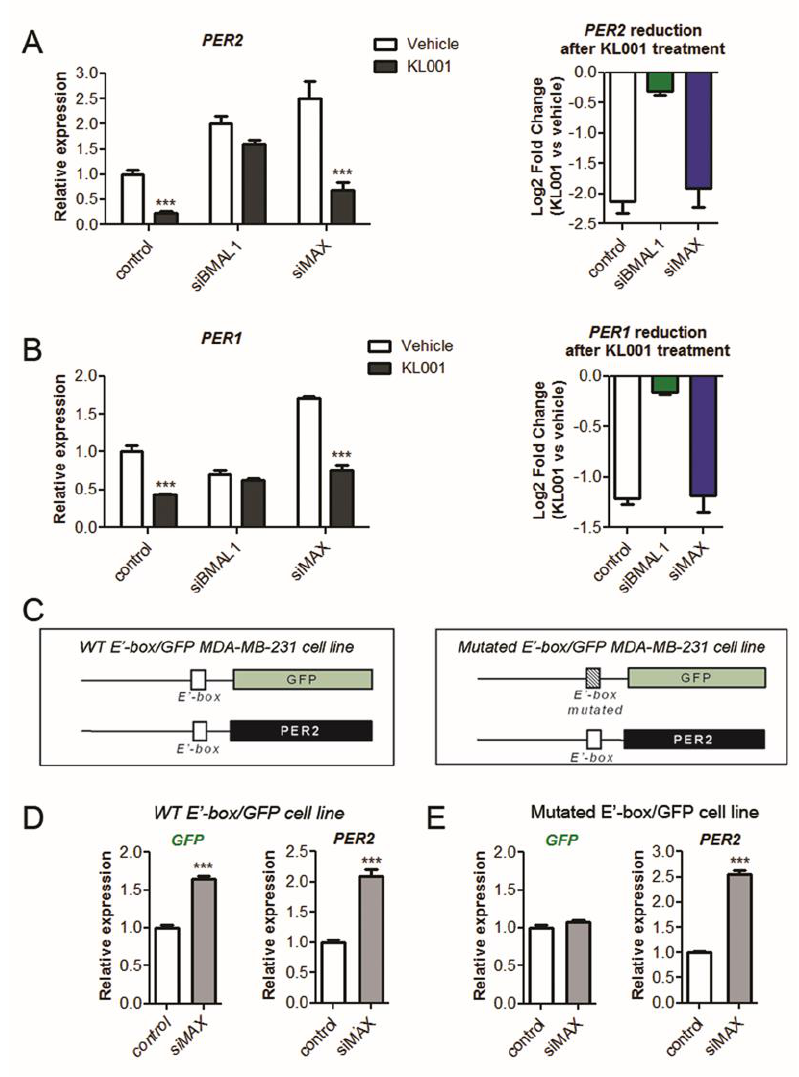
Figure 2. MAX-inhibition of the core clock genes is independent of CRY-mediated repression but requires a functional E-box responsive element. ( A , B ) MDA-MB-231 cells transfected with siRNA sequences against BMAL1 , MAX, or a non-targeting control were treated 24 h with vehicle (DMSO) or 10 µM CRY1 agonist (KL001). The effect of KL001 on the expression of CRY1 targets, PER1 and PER2 , was evaluated by qRT–PCR using GAPDH for normalization. The values of untreated control cells were set to 1. Shown as mean ± SEM, n = 3. *** p < 0.001, two-way ANOVA with Bonferroni post hoc test, vehicle versus KL001. Right panel reports the log2 ratio between KL001 and vehicle samples, thus showing reduction of PER1 or PER2 expression after the treatment with CRY agonist. ( C ) Schematic representation of two MDA-MB-231 reporter cell lines bearing the sequence coding for the green fluorescent protein (GFP) gene controlled by a promoter fragment of PER2 containing a wild-type or a mutated version of the clock regulated E’-box element ( WT E’-box / GFP and Mutated E’-box / GFP cells, respectively). ( D , E ) Expression of the endogenous PER2 gene and the GFP is driven by a WT E’-box or a mutated E’-box in reporter cells with knocked down MAX (siMAX). A non-coding siRNA was used as control. Relative expression was determined by qRT–PCR using GAPDH for normalization. The values of control cells were set to 1. Shown as mean ± SEM, n = 4. *** p < 0.001, two-tailed Student’s t -test, MAX silencing versus